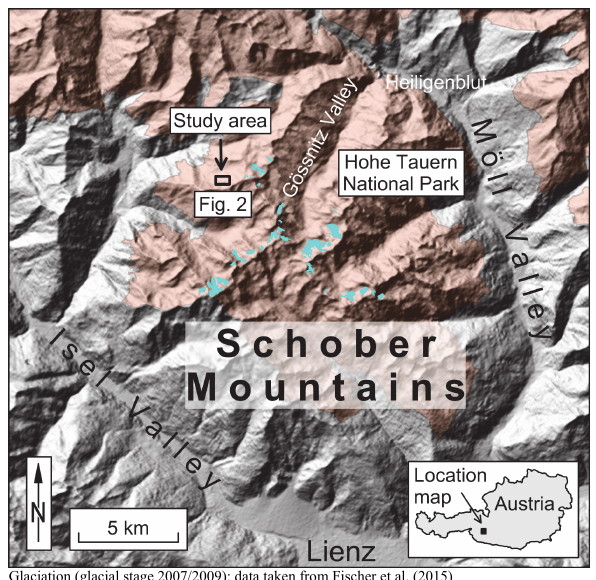
Figure 1. Location map